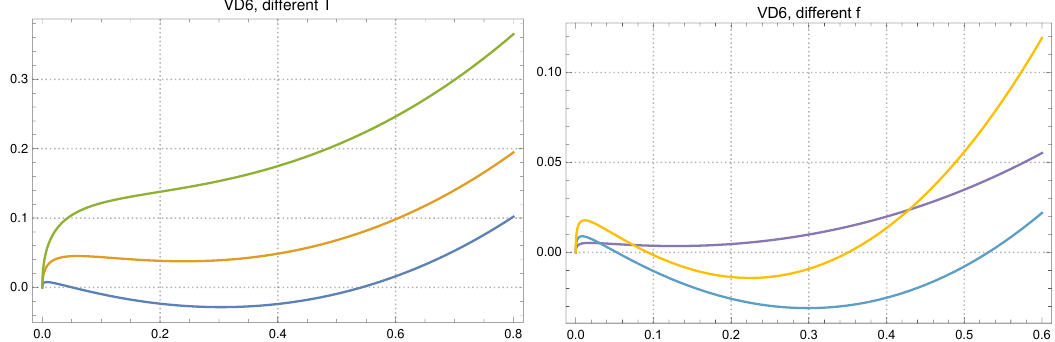
Figure 7 . D6 probe potential as a function of u for probes with worldvolume flux f = 1 on black holes with pξ = pξ = − 0 . 66 , pξ = − 0 . 089 , and different temperatures: T = 0 . 013 (blue, 1 3 2 r H = 1 / 4 ), T = 0 . 07 (orange, r H = 26 / 100 ), T = 0 . 16 (green, r H = 28 / 100 ). On the right, solutions with T = 0 . 013 , and different values f = 0 . 6 (violet), f = 1 . 1 (light blue) and f = 1 . 5 (yellow).